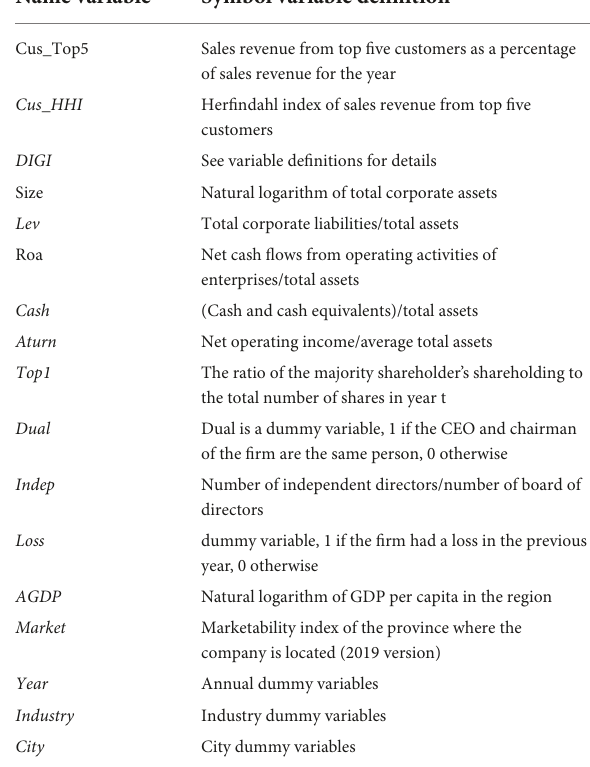
TABLE 2 Variable definitions and